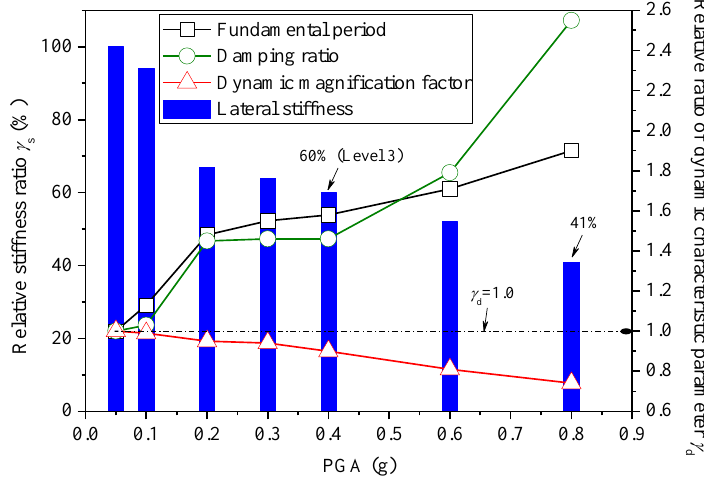
Figure 12. Relative stiffness ratio and relative ratios of dynamic characteristic parameters under PDTs.